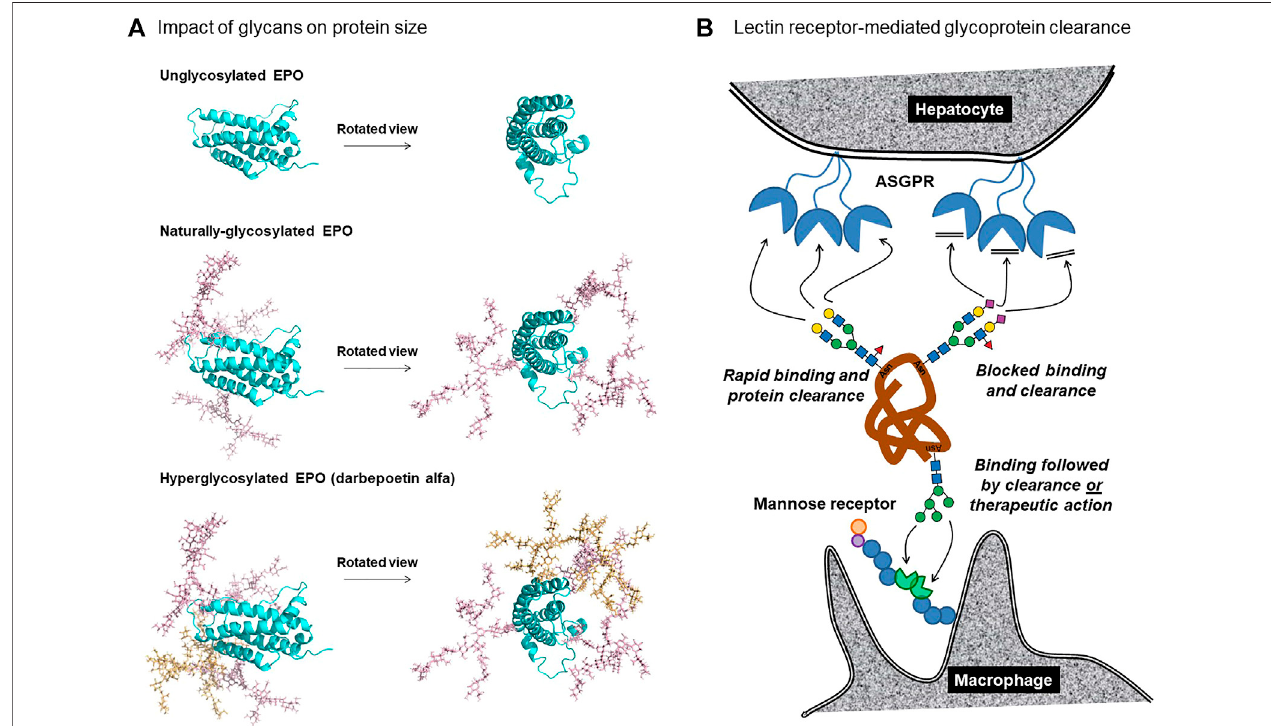
FIGURE 2 | N-glycans in fl uence the clearance of therapeutic proteins based (A) on size and (B) receptor-mediated clearance. (A) Unglycosylated EPO (top) is comparedwithnaturallyglycosylatedEPO,whichhasthreeN-glycansatAsn24,N38,andN83(middle)andwithdarbepoetinalfa,whichhas fi veglycansincludingthose newly-added at Asn30 and N88 (bottom). The glycan structures depicted are representative of the experimentally-determined N-glycan pro fi le of EPO (Cowper et al., 2018),inparticular thestructure shownin Figure1E(vii) .ProteinmodelsweregeneratedusingSWSS-MODELsoftware (Waterhouseetal.,2018)andmodi fi edto present N-glycan structures via CHARMM (Jo et al., 2008) and PyMOL (PyMOL Molecular Graphics System, Version 2.0, Schrödinger, LLC). The darbepoetin alfa sequencewasobtainedfromtheKEGGDrugdatabase. (B) Lectinreceptor-mediatedclearanceremovesproteinsfromcirculationthroughASPGRbindingofgalactose- terminated glycans (top left); addition of sialic acid masks the galactose blocking binding and clearance (top right). Mannose-terminated glycans bind to mannose receptors on macrophages, dendritic cells, dermal fi broblasts, and keratinocytes, resulting in clearance or, in some cases, therapeutic activity [for example to treat Gaucher disease ( Section 2.3.3